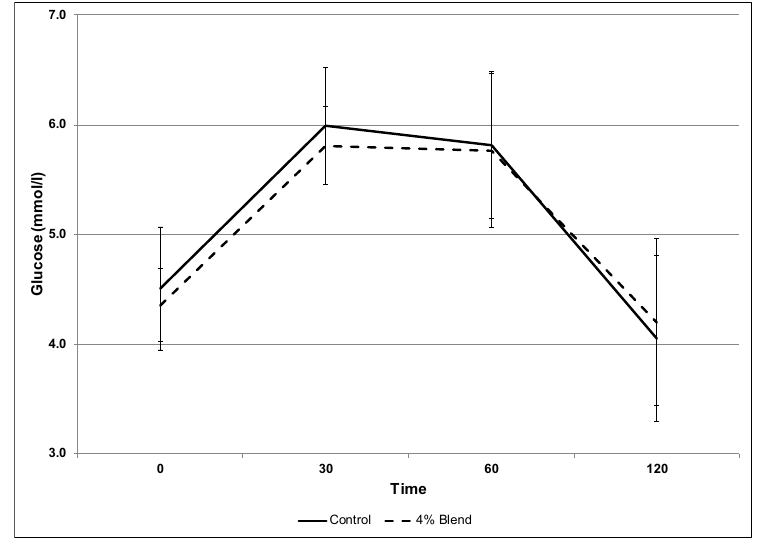
Figure 4. Comparison of blood glucose value averages ( n = 10) at 0, 30, 60, and 120 min for the control and 4% blend.